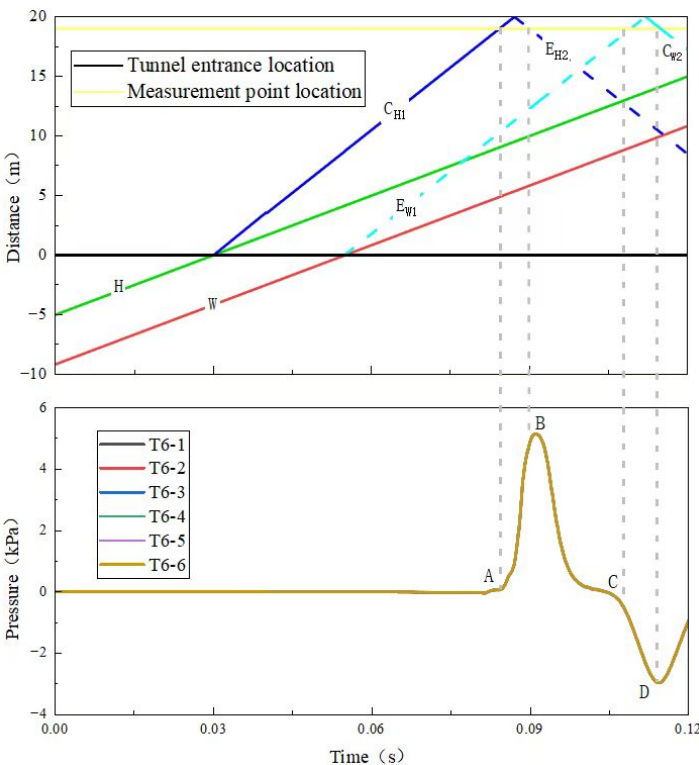
Figure 9. Pressure–time history curve of different measuring points in the same section.